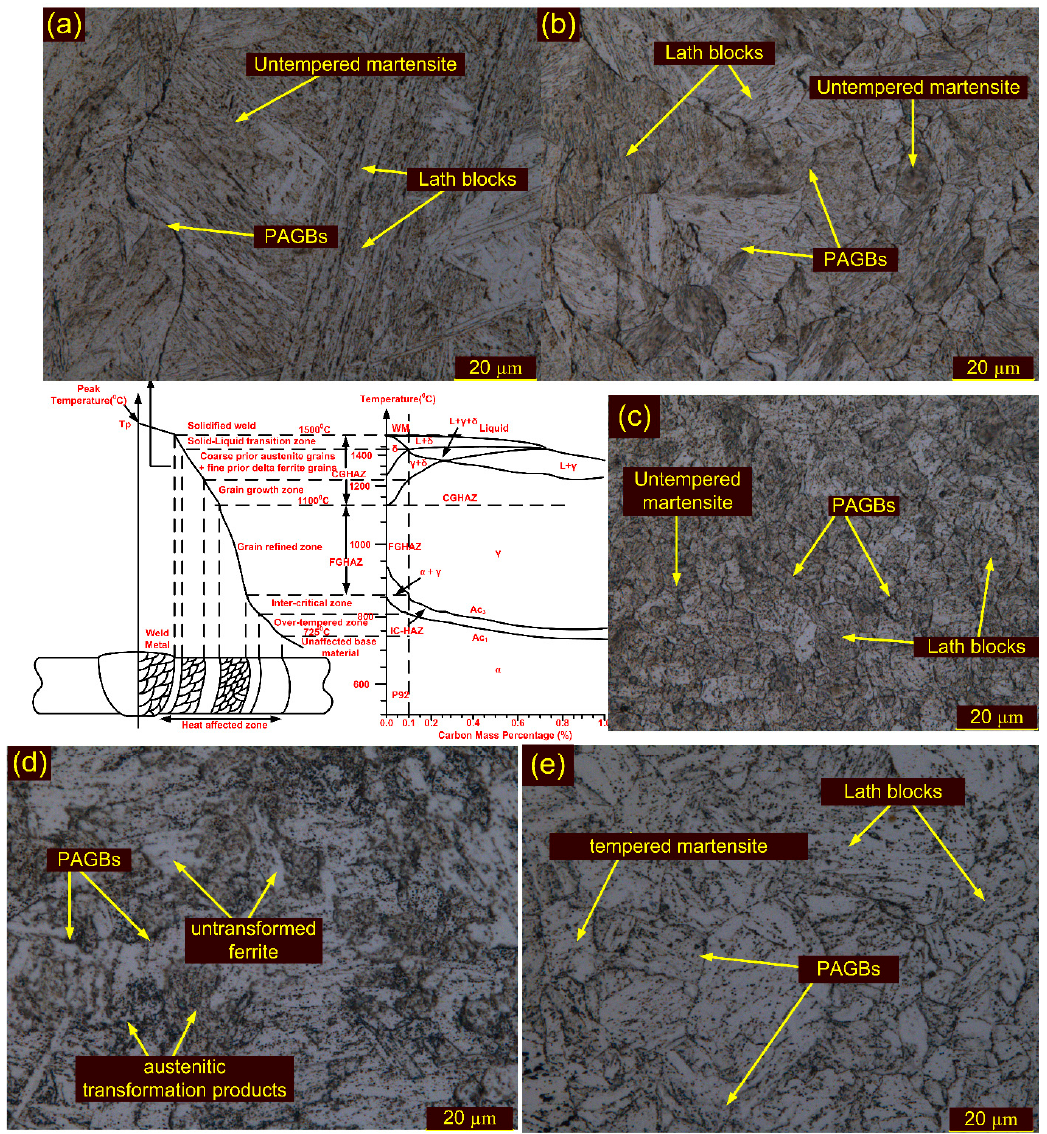
Figure 5. Fe–C diagram showing the formation of various zones in P92 weldments corresponding to different peak temperatures, and optical images of weldments: ( a ) WFZ, ( b ) CGHAZ, ( c ) FGHAZ, ( d ) ICHAZ, ( e )